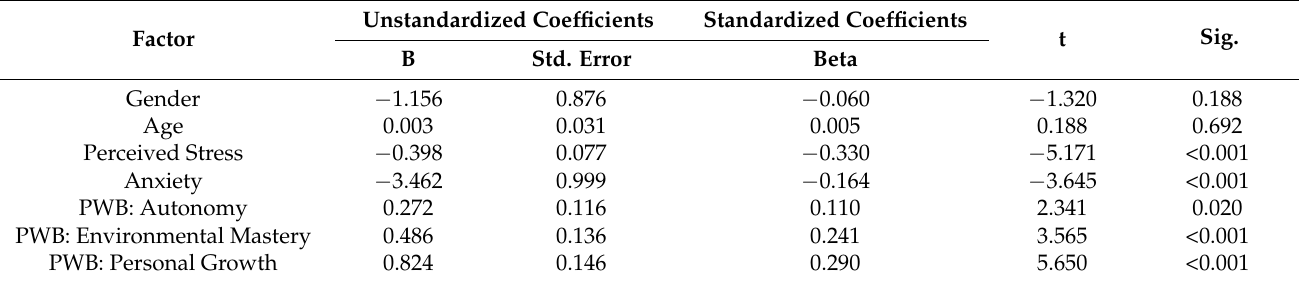
Table 6. Resilience: a multivariable linear model.